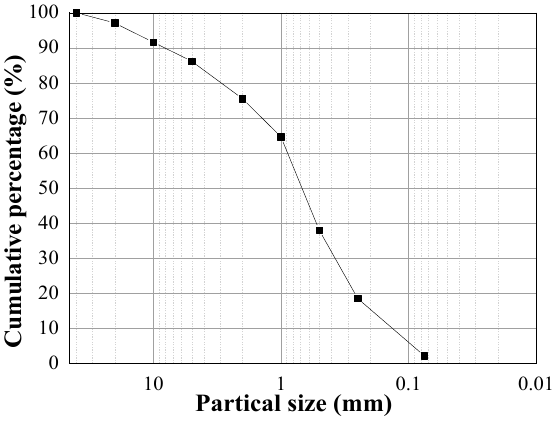
Figure 2. Grain gradation curve of natural weathered sand. Table 1. Basic physical indexes of the natural weathered